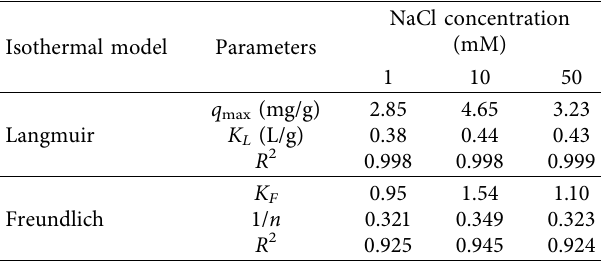
Table 1: Parameters of TC adsorption isotherms onto NCPML at different NaCl concentrations using Langmuir and Freundlich